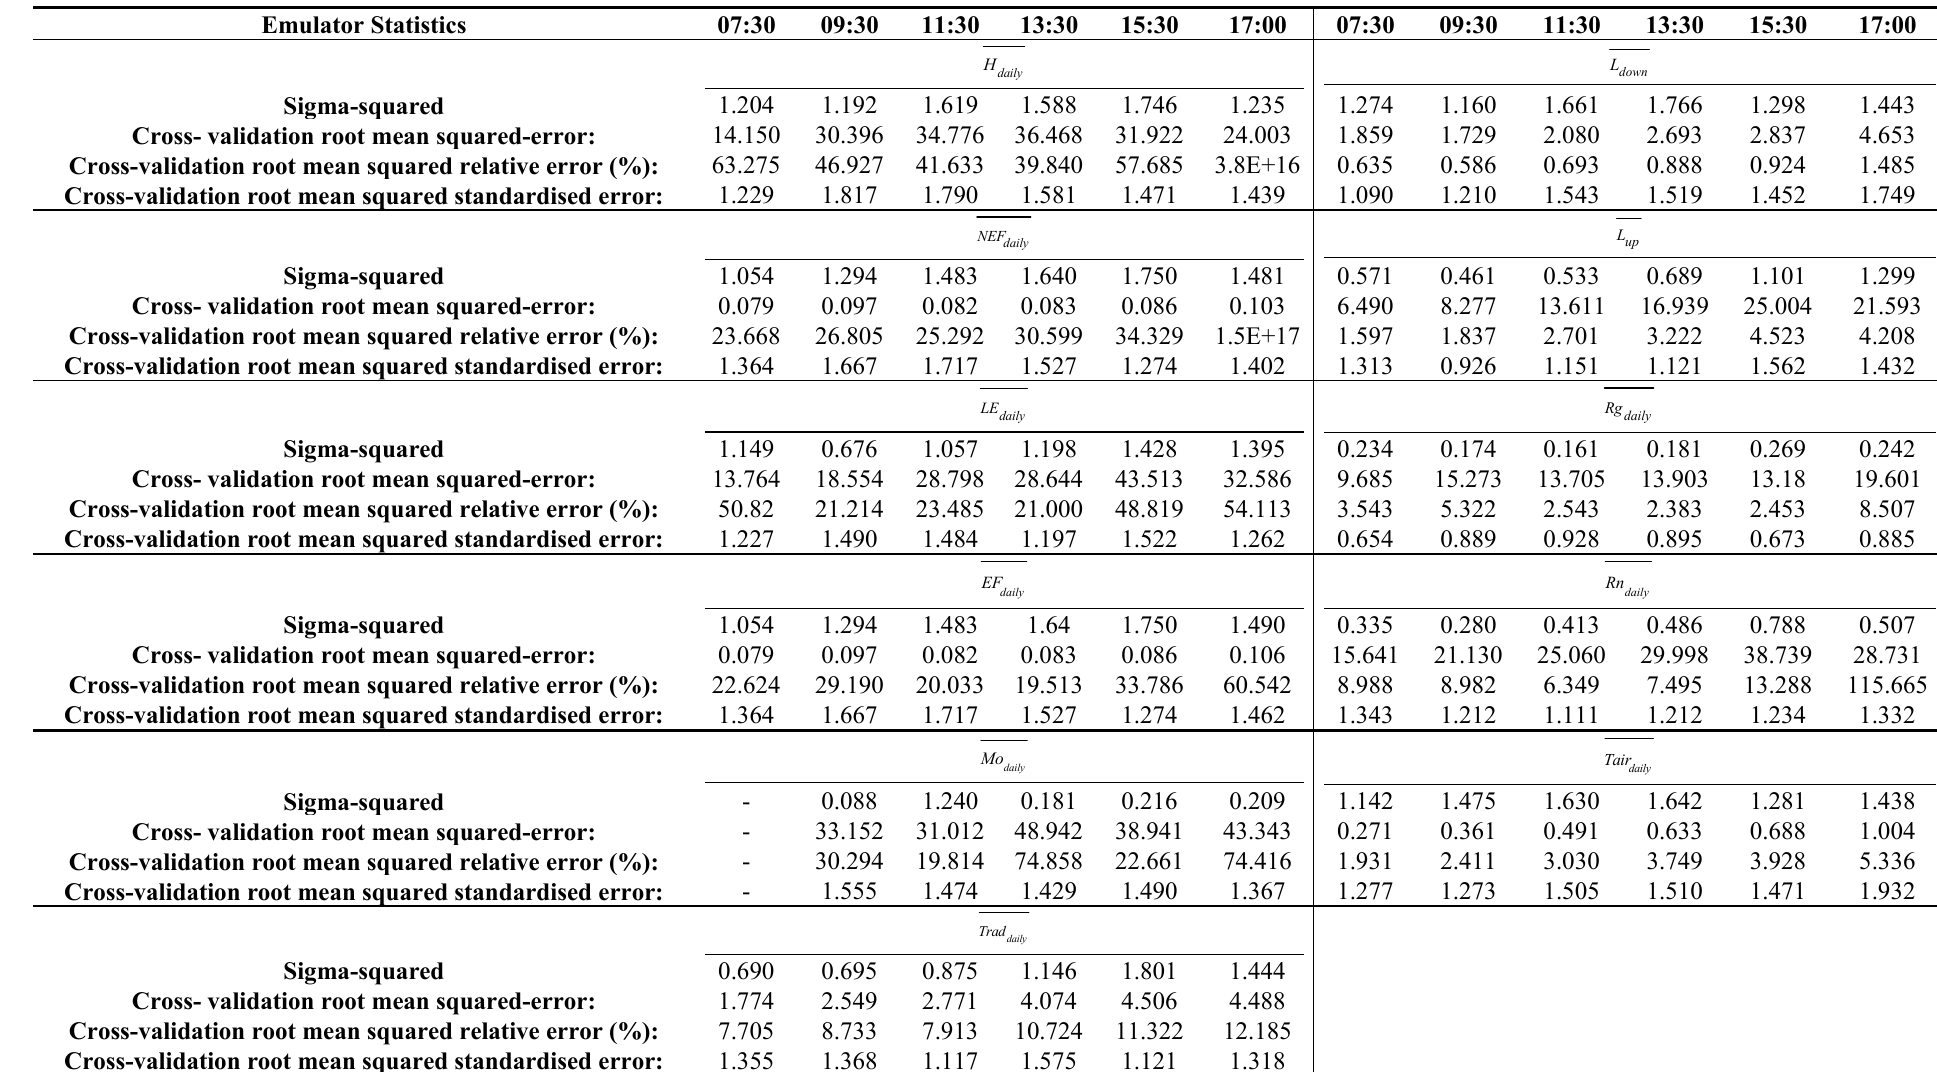
Table 3. Emulator performance statistics for the SA tests conducted in our study under uniform PDF assumptions for the model inputs/outputs at each different time